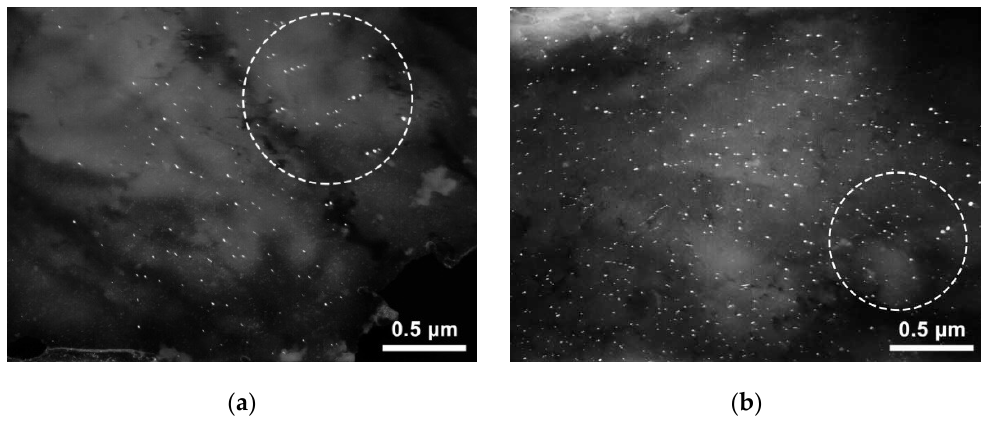
Figure 9. Dark-field image in the reflections of nanosized carbonitrides (steel No 14): ( a ) Area with precipitates of interphase type (circled); ( b ) Areas with precipitates formed in ferrite (circled).